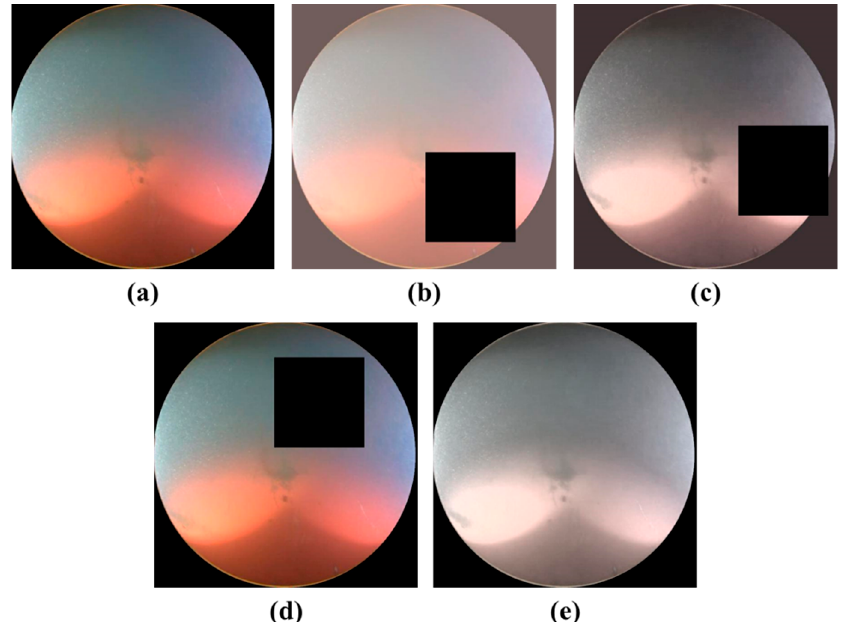
Figure 5. Examples of augmented images: ( a ) original image; ( b ) brightness, contrast, and cropping; ( c ) brightness, contrast, saturation, and cropping; ( d ) cropping; ( e ) saturation. Table 3. Configuration of the training, validating, and test datasets.